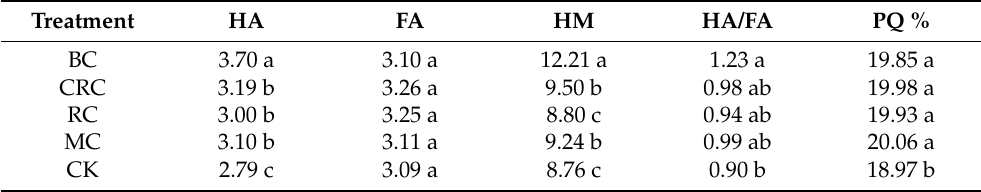
Table 7. Soil humus under different organic material treatments in 2018 (g kg − 1 ).